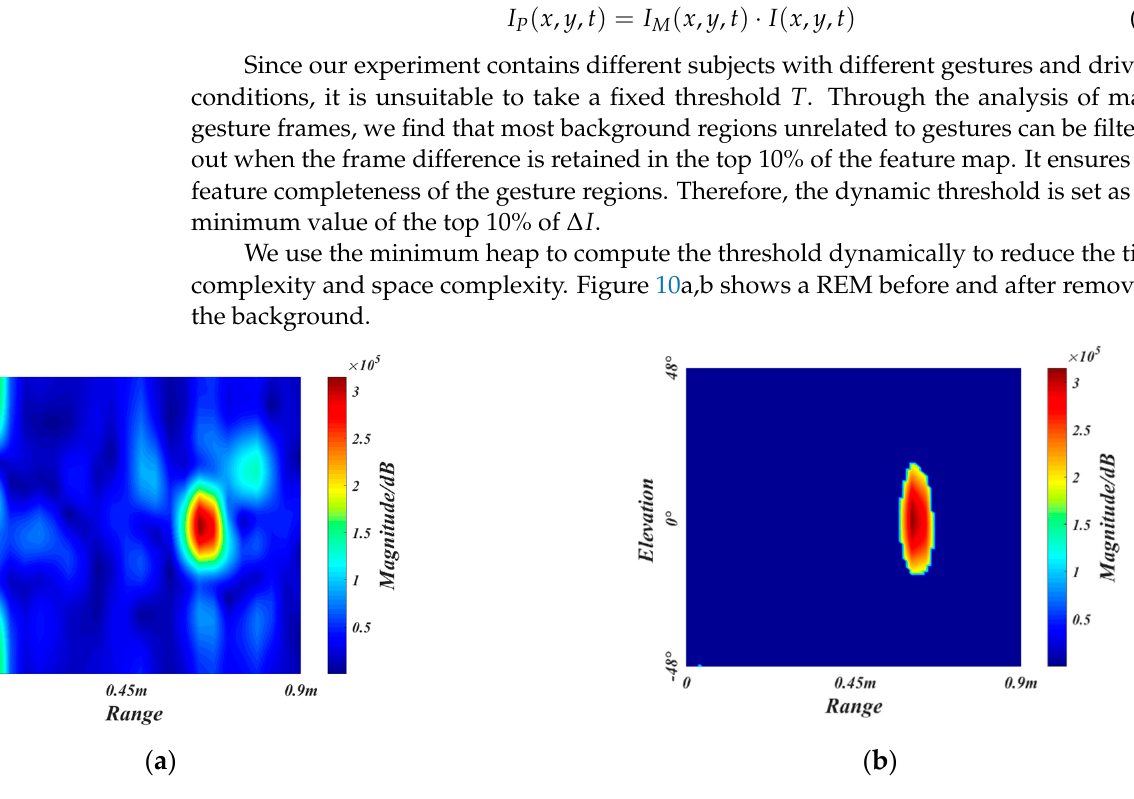
Figure 10. The results of the background removal algorithm. ( a , b ) are the figure before and after background removal, respectively.